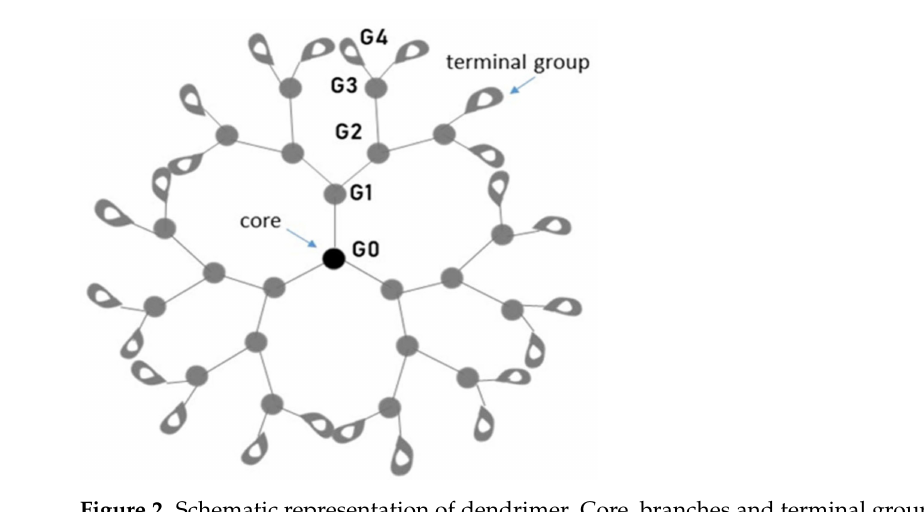
Figure 2. Schematic representation of dendrimer. Core, branches and terminal groups are present from the inside to the outside of the